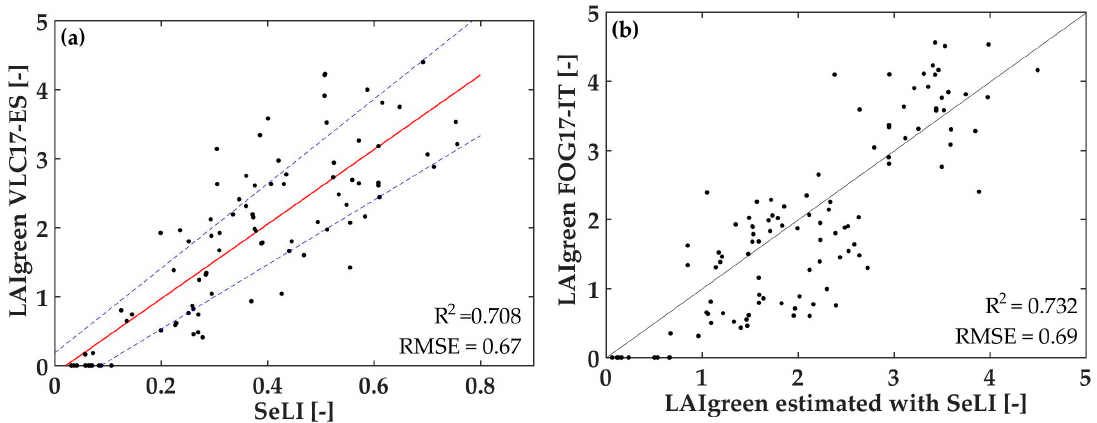
Figure 7. ( a ) Graphic representation of the LAI green of the testing VLC17_ES dataset (n = 92) as a function of SeLI, the index proposed, with linear fit and 95% of confidence interval, ( b ) LAI green in situ validation data from FOG17_IT (n = 109) as a function of LAI green estimated with SeLI, with 1:1 line and its statistics.